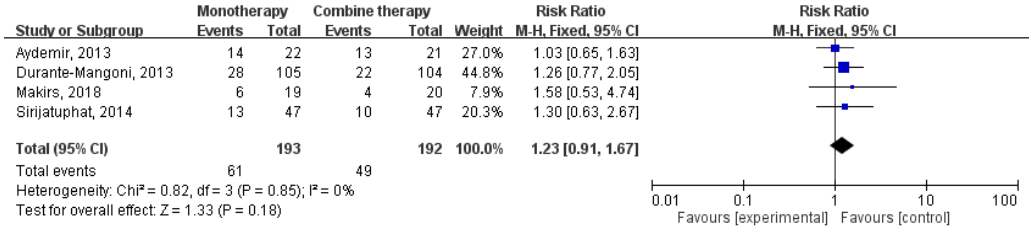
Figure 4. Colistin monotherapy versus colistin-based combination therapy, all-cause mortality. M-H, Mantel-Haenszel.